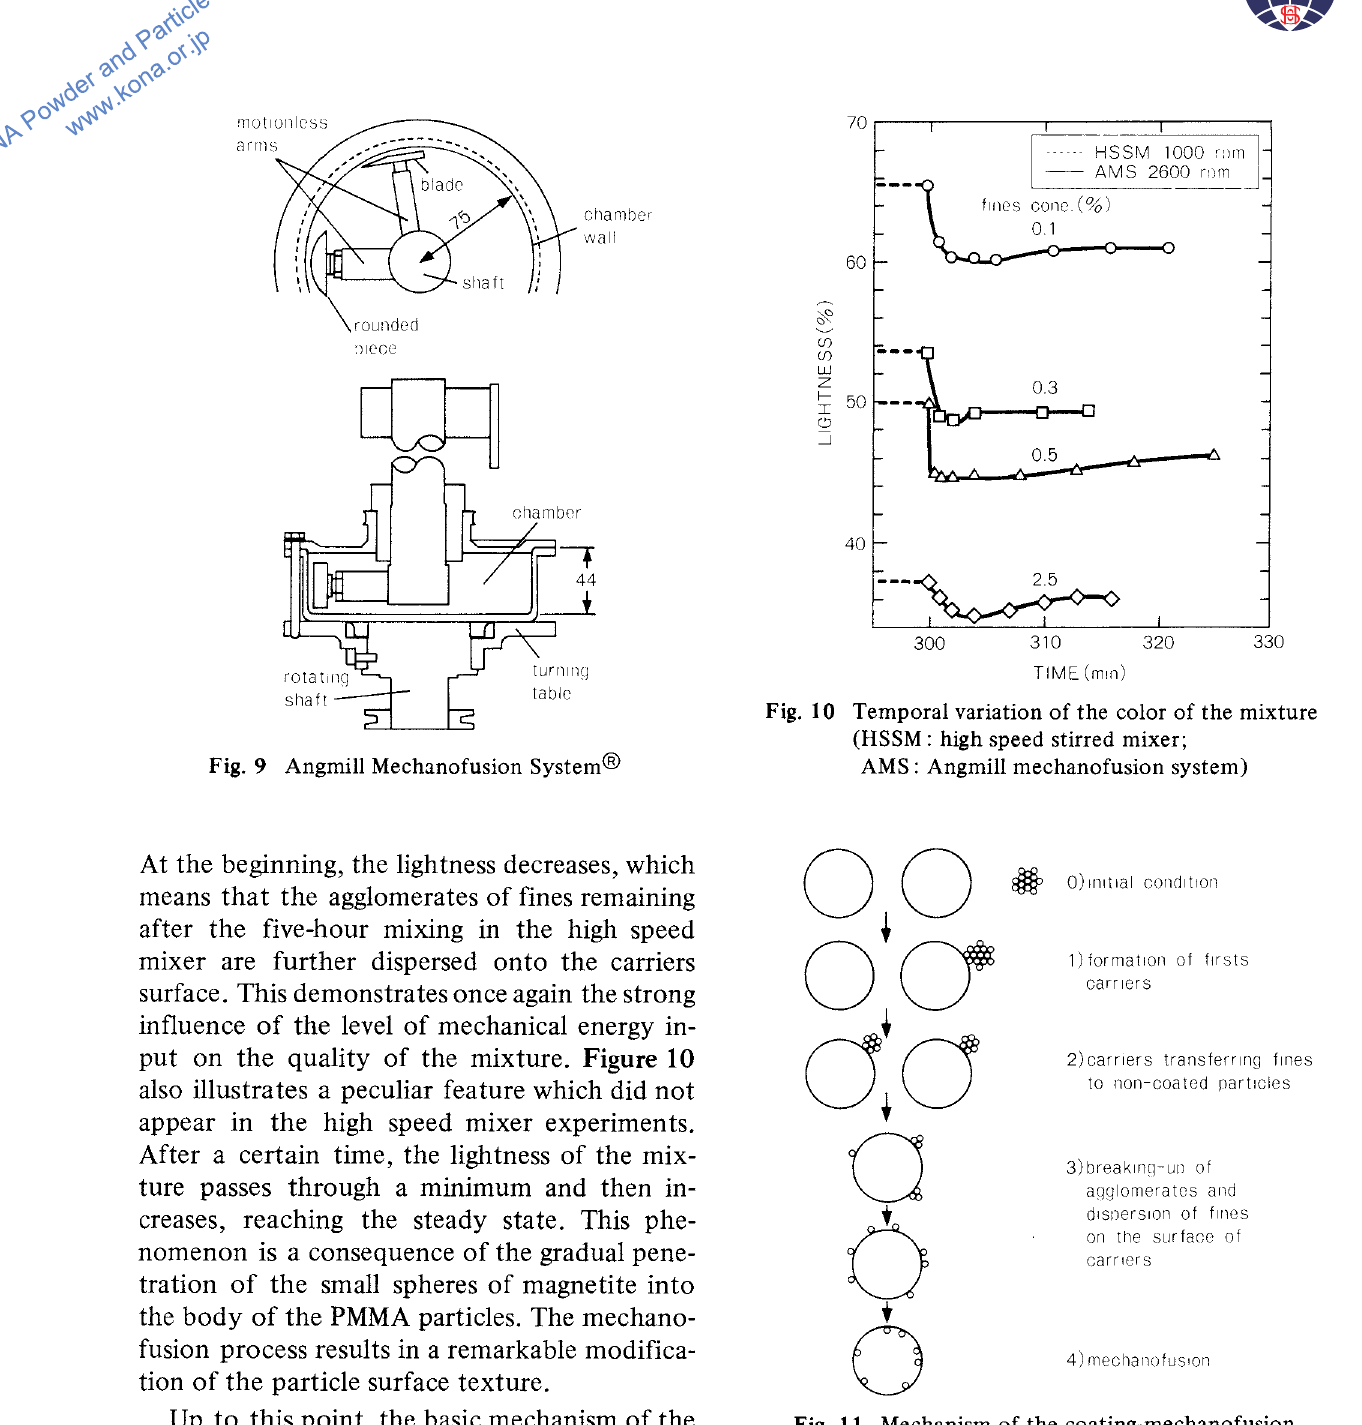
Fig. 11 Mechanism of the coating-mechanofusion